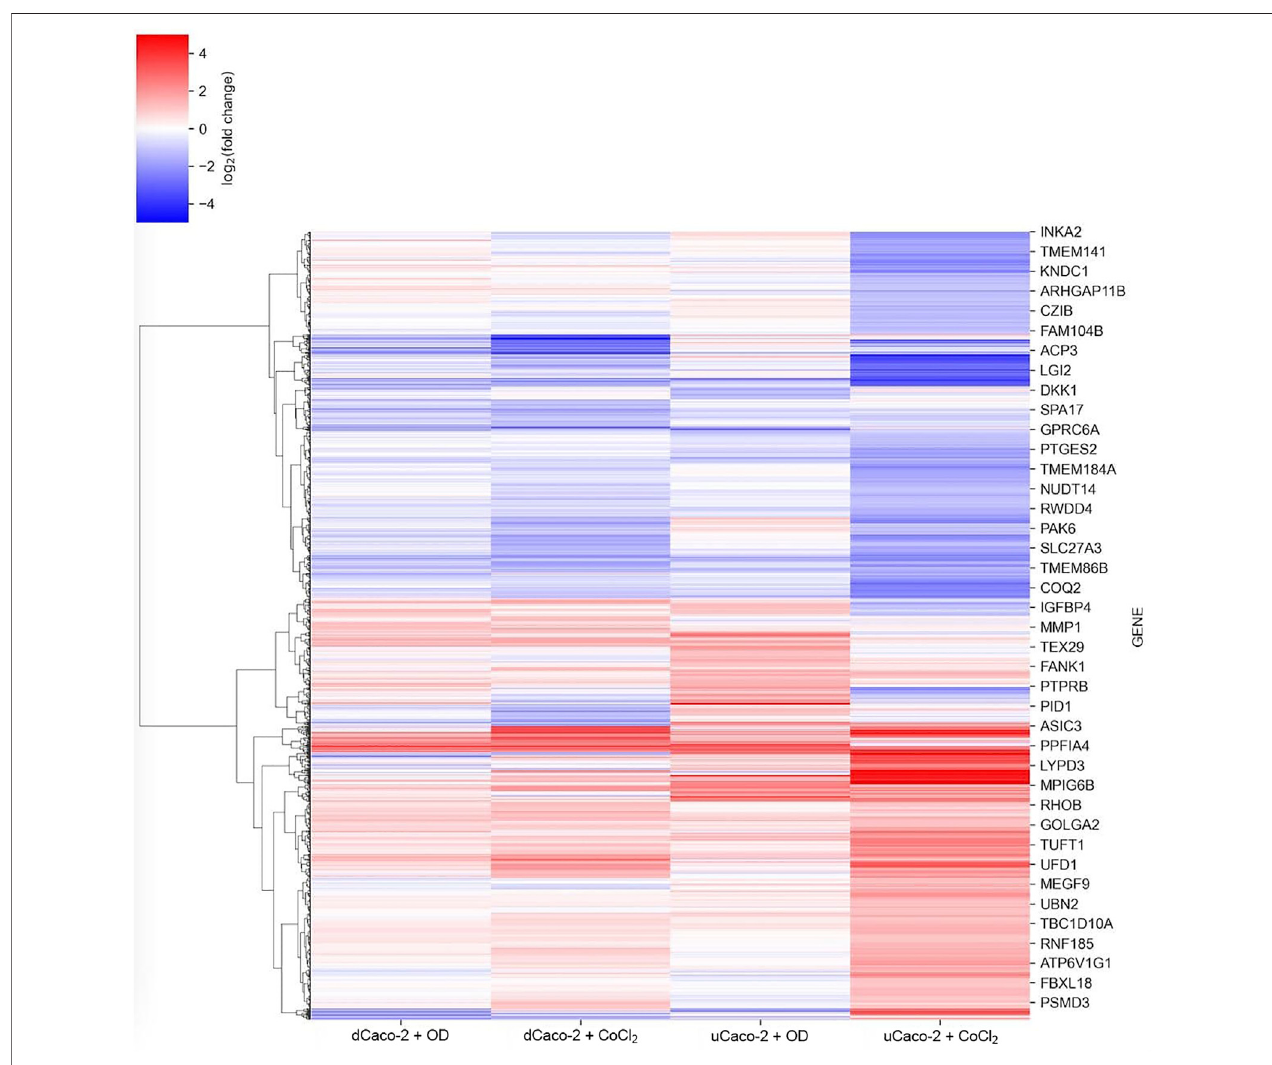
FIGURE 1 | mRNA expression changes for differentiated Caco-2 (dCaco-2) and undifferentiated Caco-2 (uCaco-2) upon cobalt (II) chloride (CoCl 2 ) and oxyquinoline derivative (OD) treatment. The heatmap includes genes with differential expression in at least one combination of cell line and treatment.